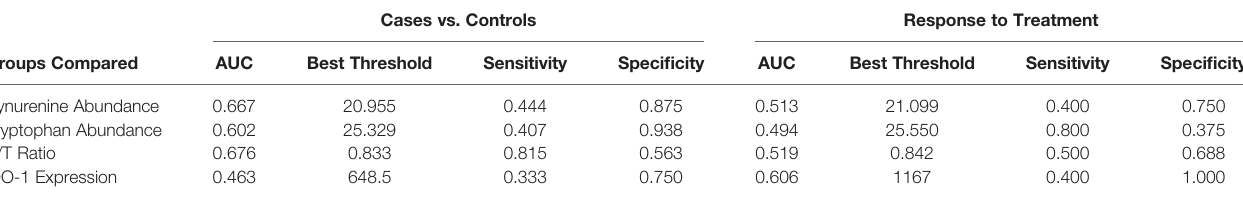
TABLE 2 | Test characteristics of kynurenine and tryptophan abundance, the K/T ratio, and IDO-1 expression for the diagnosis of pediatric tuberculosis and treatment response. Cases vs. Controls